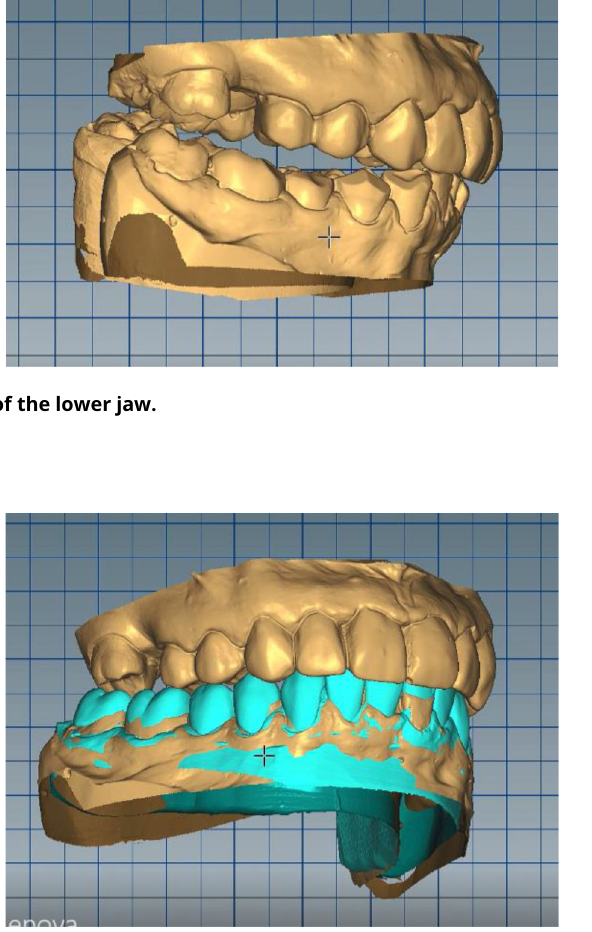
Figure 13. Design of the final restoration.